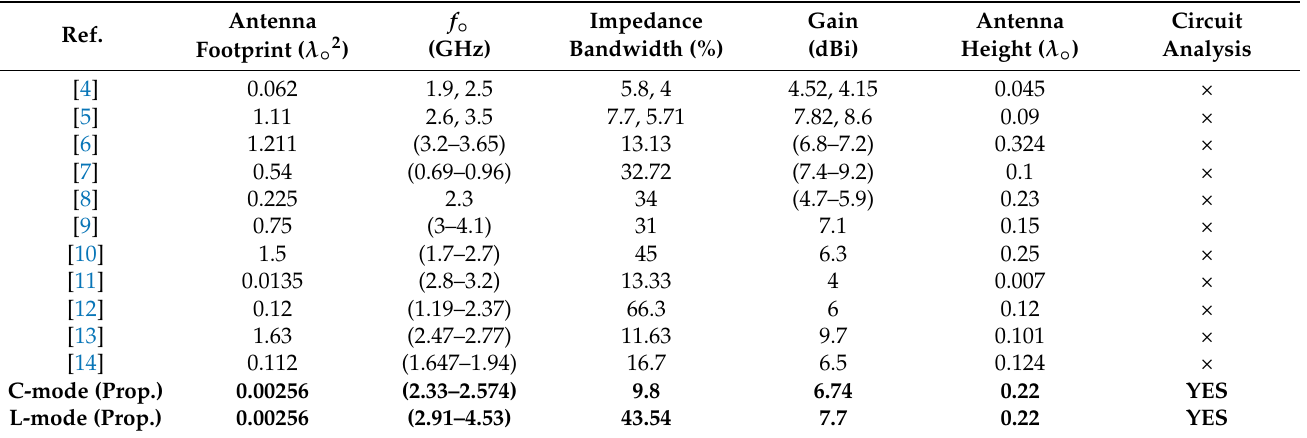
Table 4. The performance comparison of proposed antenna configuration over the reported antenna designs in